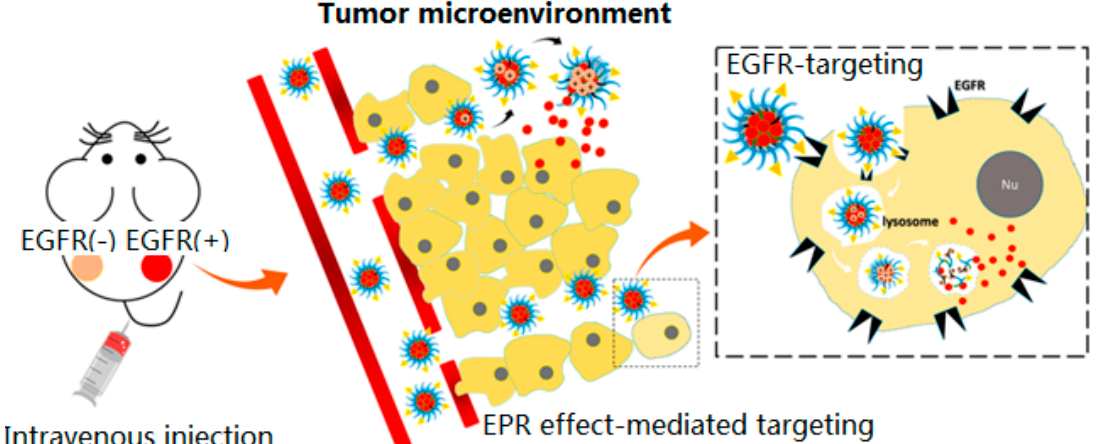
Figure 4. Schematic diagram of accumulation mechanisms of Ce6/GE11-(pH) micelle according to the EPR effect and EGFR targeting and successful Ce6 release in slightly acidic tumor microenvironments or lysosomes after EGFR-mediated endocytosis. Copyright (2018) American Chemical Society [116].